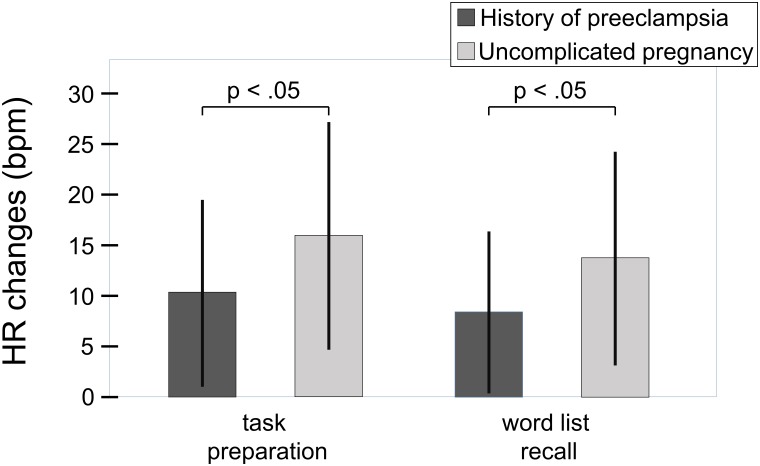
Heart rate responses to the challenge relative to initial resting period in women with history of preeclampsia (n = 30) and women with uncomplicated pregnancies (n = 40). Whiskers represent standard deviations. Independently from chronic stress experience, women with a history of preeclampsia showed smaller heart rate responses than women with uncomplicated pregnancies (word list recall: sr = –0.29, p = 0.018; sr2 = 0.084; F(3,66) = 3.9, p = 0.013; task preparation: sr = –0.28, p = 0.020, sr2 = 0.078; F(3,66) = 3.8, p = 0.015).